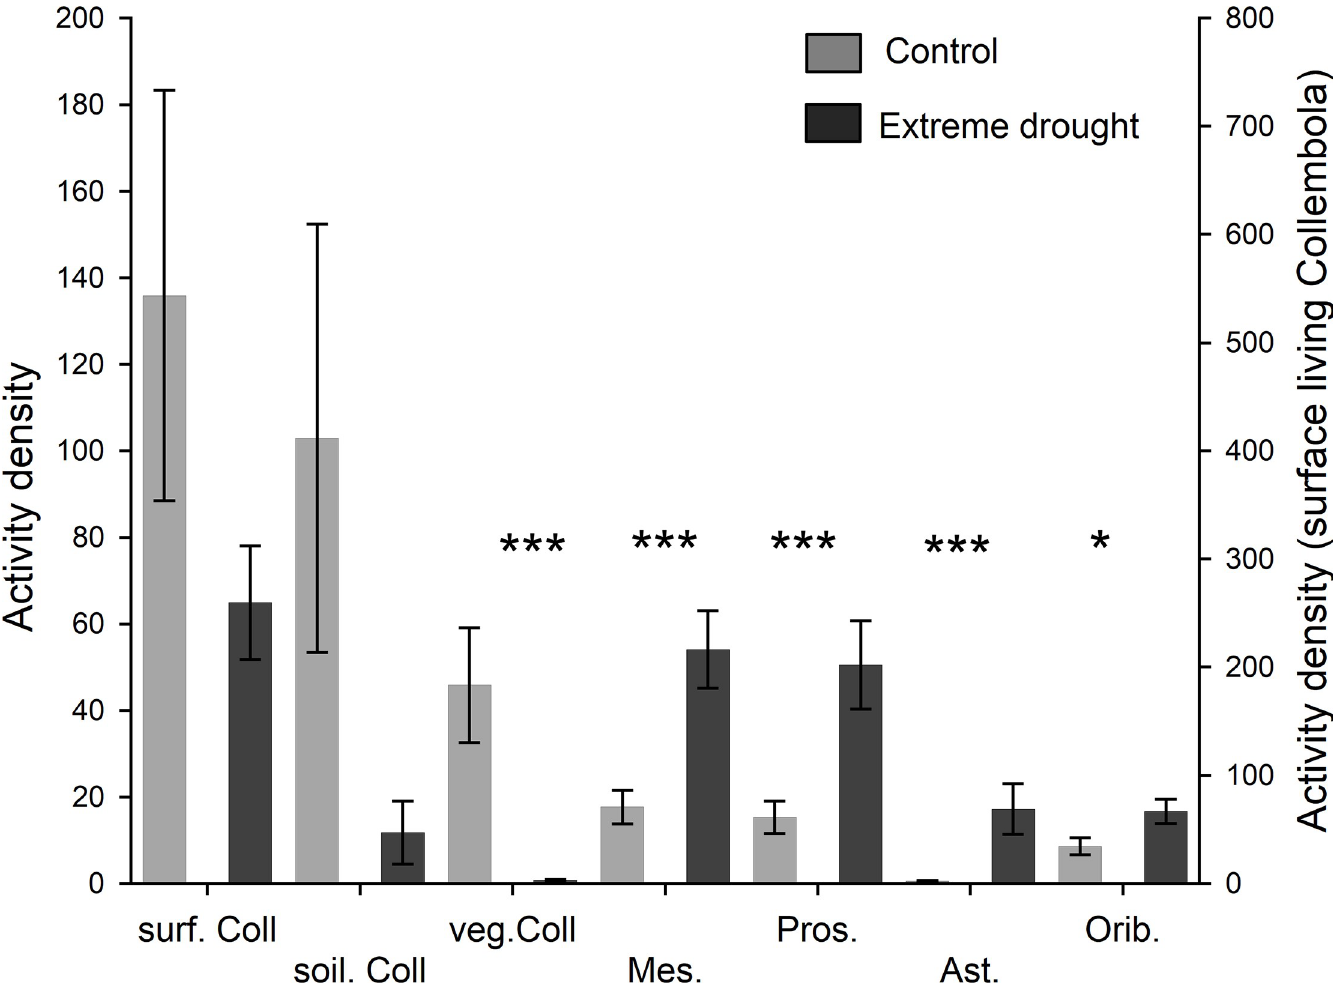
Fig 1. Activity densities of soil mesofauna groups. Mean activity density ± standard error values of different soil mesofauna groups in extreme drought (dark grey) and control plots (light grey) during the experiment. Left axis: soil Coll (hemi- and euedaphic Collembola), veg. Coll (vegetation-living Collembola), Mes. (Mesostigmata), Pros. (Prostigmata), Ast. (Astigmata), Orib. (Oribatida). Right axis: surf. Coll (epedaphic Collembola). Comparisons were performed with ln(x+1)-transformed data according to Student’s t tests ( � : p < 0.05, ��� : p < 0.001).